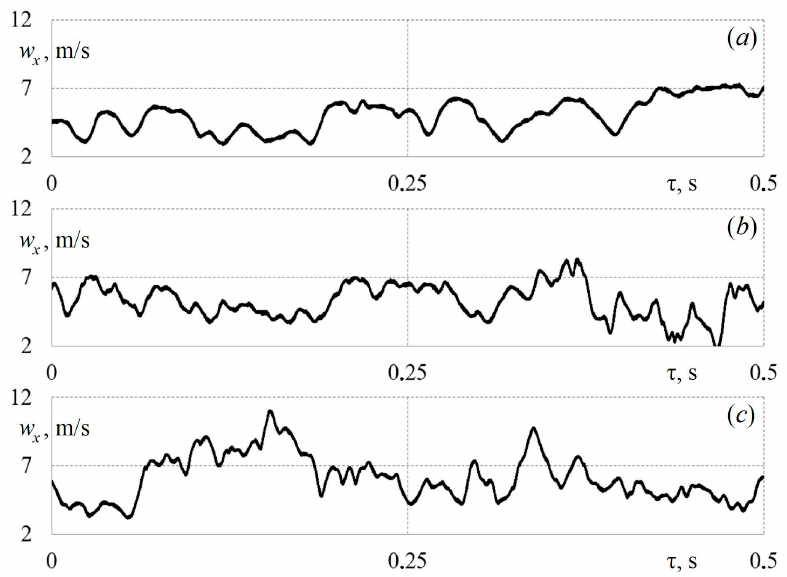
Figure 3. Dependences of local values of air flow velocity w x on time τ in the first control section ( H 1 = 100 mm) for a sensor in the centre of the installation ( l 5 = 50 mm) for supply tube configurations: ( a )—round tube (average parameters in cross section: w 1 = 4.2 m/s, TI = 0.231); ( b )—square tube ( w 1 = 4.45 m/s, TI = 0.18); ( c )—triangular tube ( w 1 = 4.48 m/s, TI = 0.285).